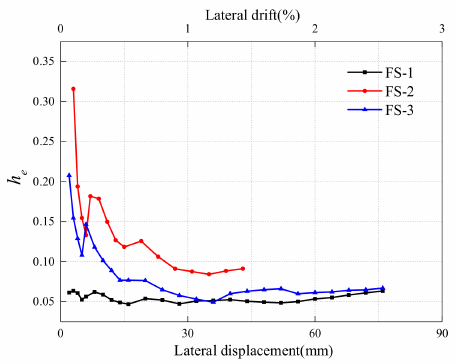
Figure 14. Equivalent viscous damping